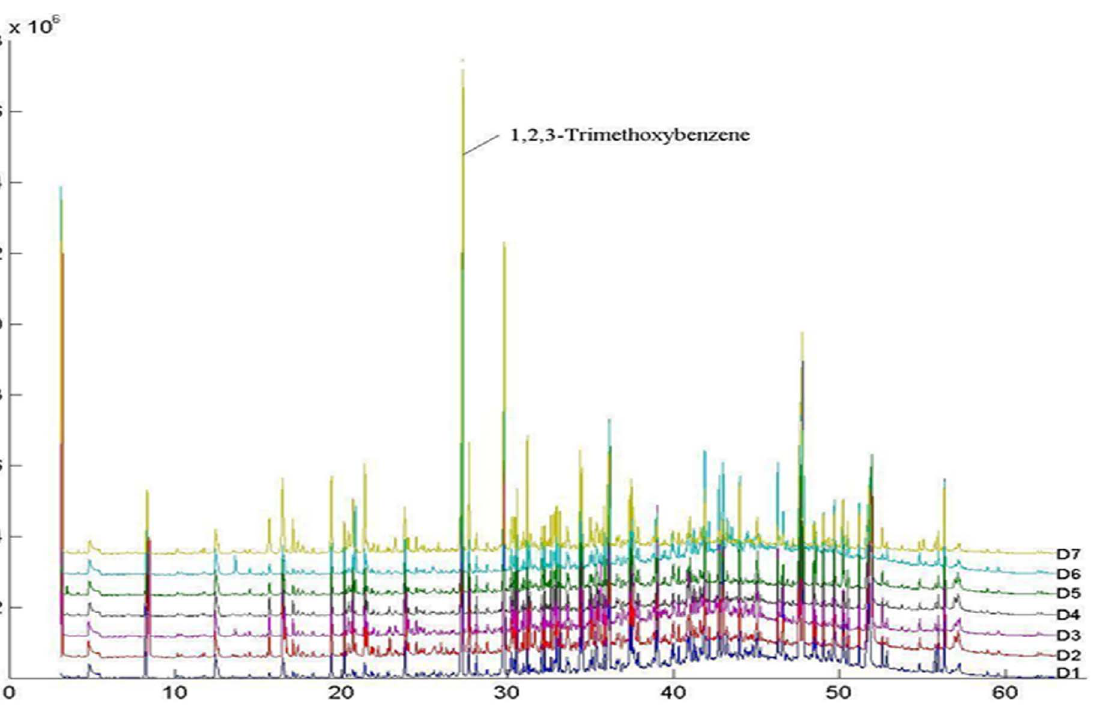
Fig. 1. The overlapping plots of the GC-MS fingerprints in seven Dayi Pu-erh tea samples. D1–D7 represent different brands Dayi Pu-erh tea samples. 1,2,3-Trimethoxybenz in the figure was used as internal standard peak for calculating the relative retention value of other peaks.